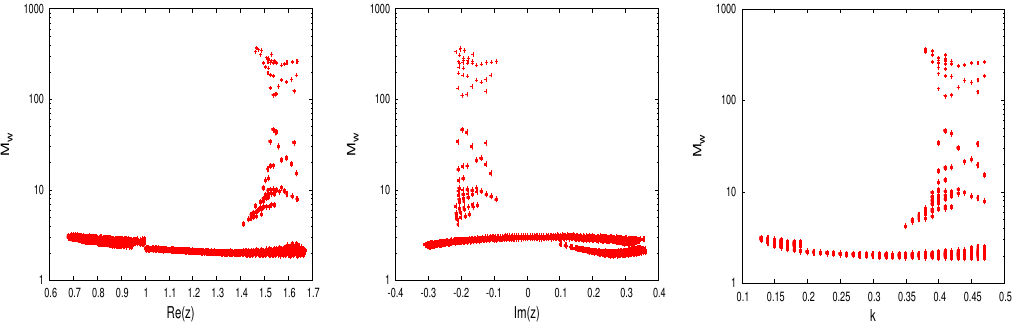
Figure 12 . The allowed range of M w constrained by the baryon asymmetry bound for the whole 3 (cid:27) parameter space of oscillation data. Y B is calculated using (cid:20) f taken into